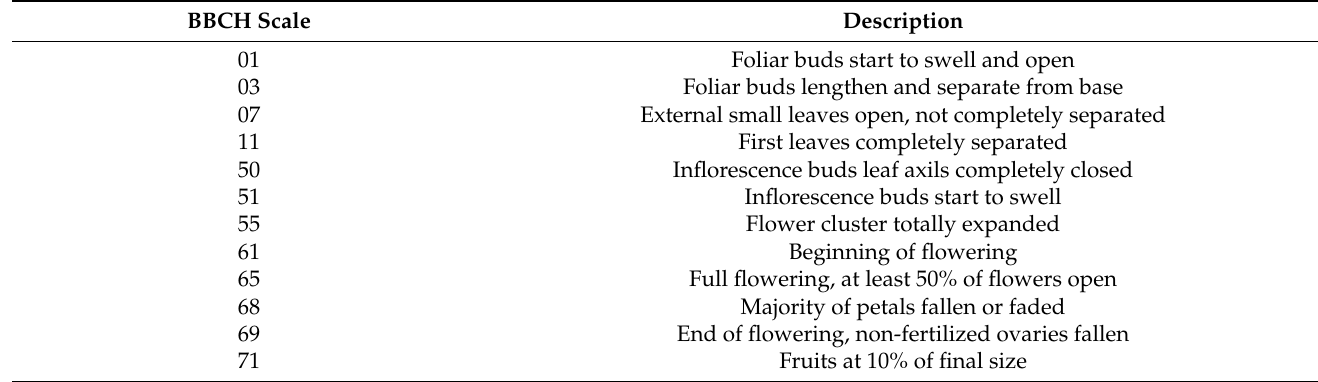
Table 2. Observed phenological events for Olea europaea under the PHENAGRI project. BBCH